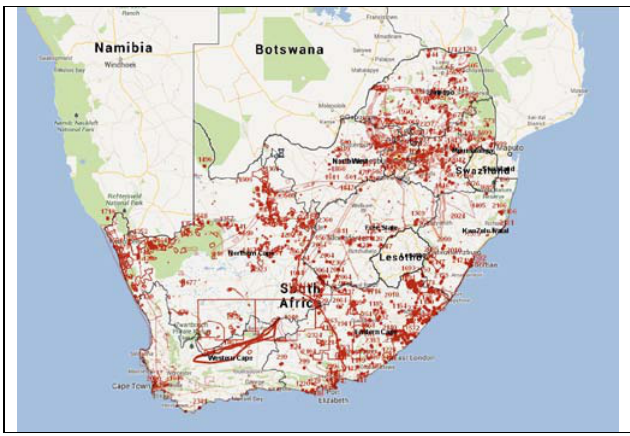
Figure 1. View of developments mapped on SAHRIS dating back to the 1980s.